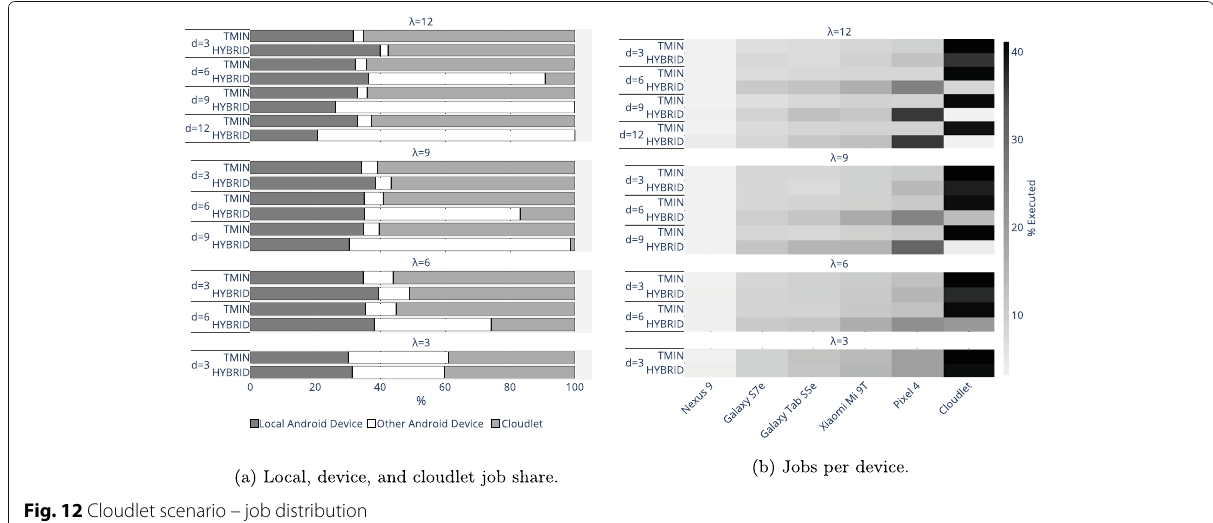
Fig. 12 Cloudlet scenario – job distribution